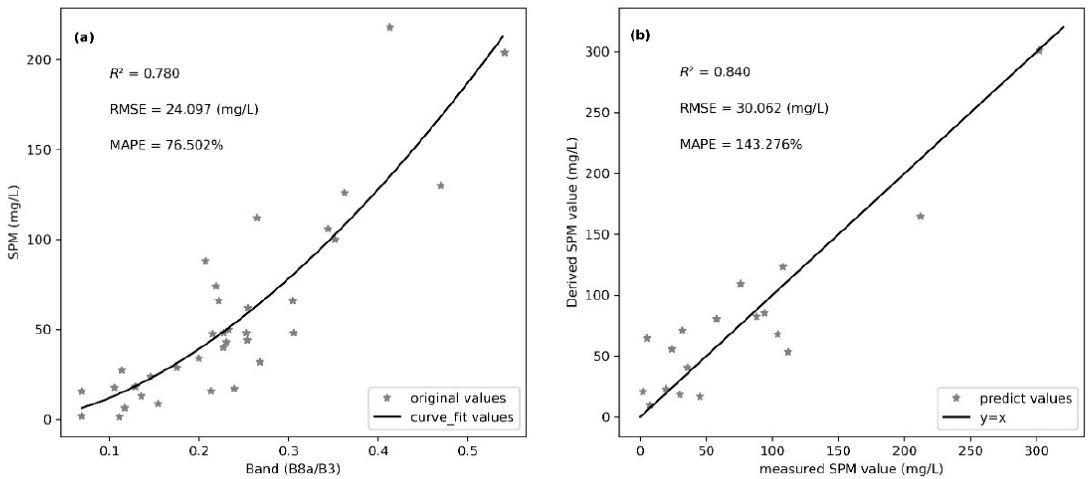
Figure 3. Accuracy assessment of SPM retrieval model for OLI and MSI sensors in Shengjin lake. ( a ) Calibration accuracy, ( b ) validation accuracy.